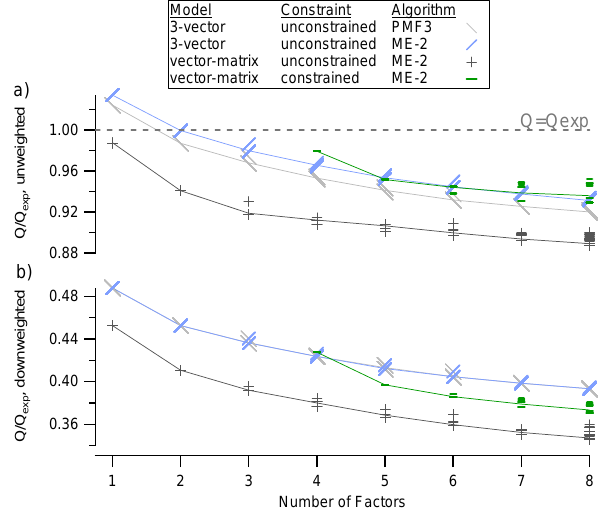
Fig. 3. Values of Q/Q exp for the 3-vector and vector-matrix fac- torization models with 1 to 8 factors. Two algorithms were used to solve the two models: PMF3, which can only solve the 3-vector model; and ME-2, which can solve a variety of factorization mod- els. Each mark shows the Q/Q exp value of one of 50 seeds used to start the algorithm. Lines connect the average Q/Q exp value of the 50 seeds for each model-algorithm combination. Marks that appear as an “X” are the intersection of “/” and “ \ ”. In the constrained vector-matrix case (green dashes), the mass spectra of four factors are fully constrained as described in the text. (a) Q/Q exp values have been recalculated without downweighting. (b) Q/Q exp val- ues were calculated with the downweighted error